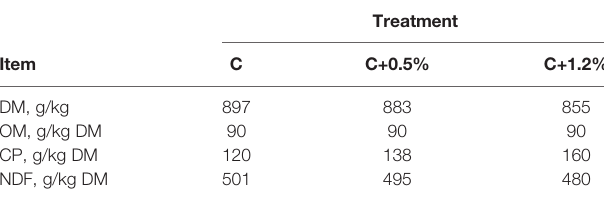
TABLE 1 | Chemical composition of diets.